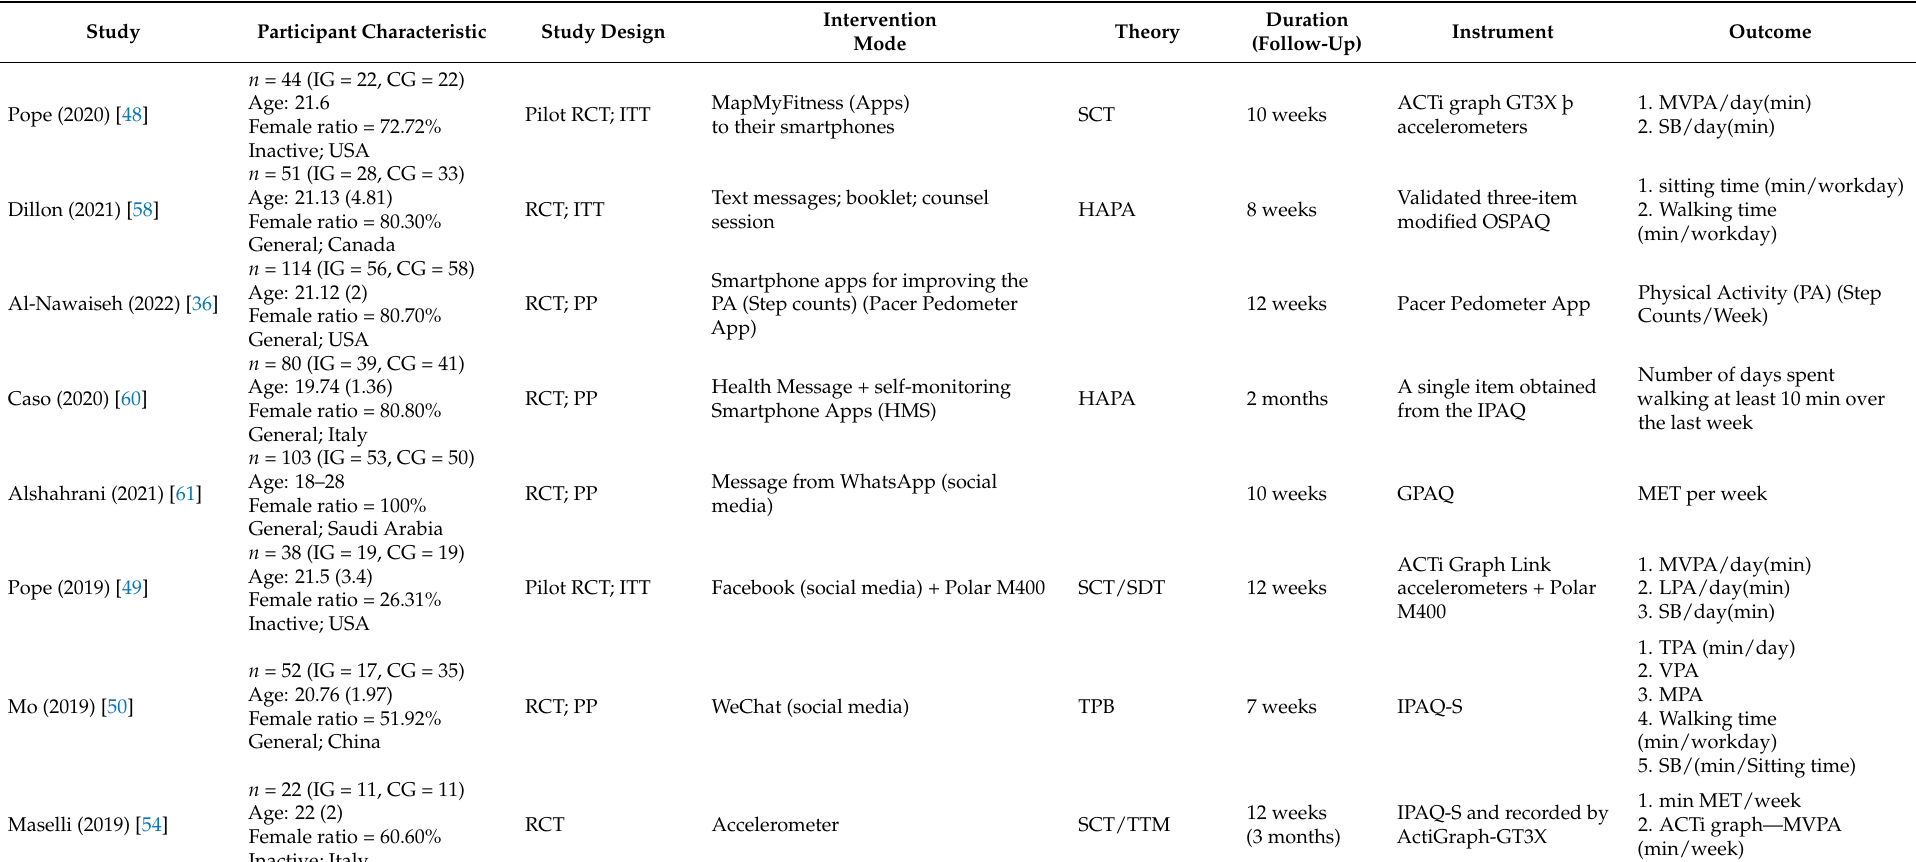
Table A1. Characteristics of included